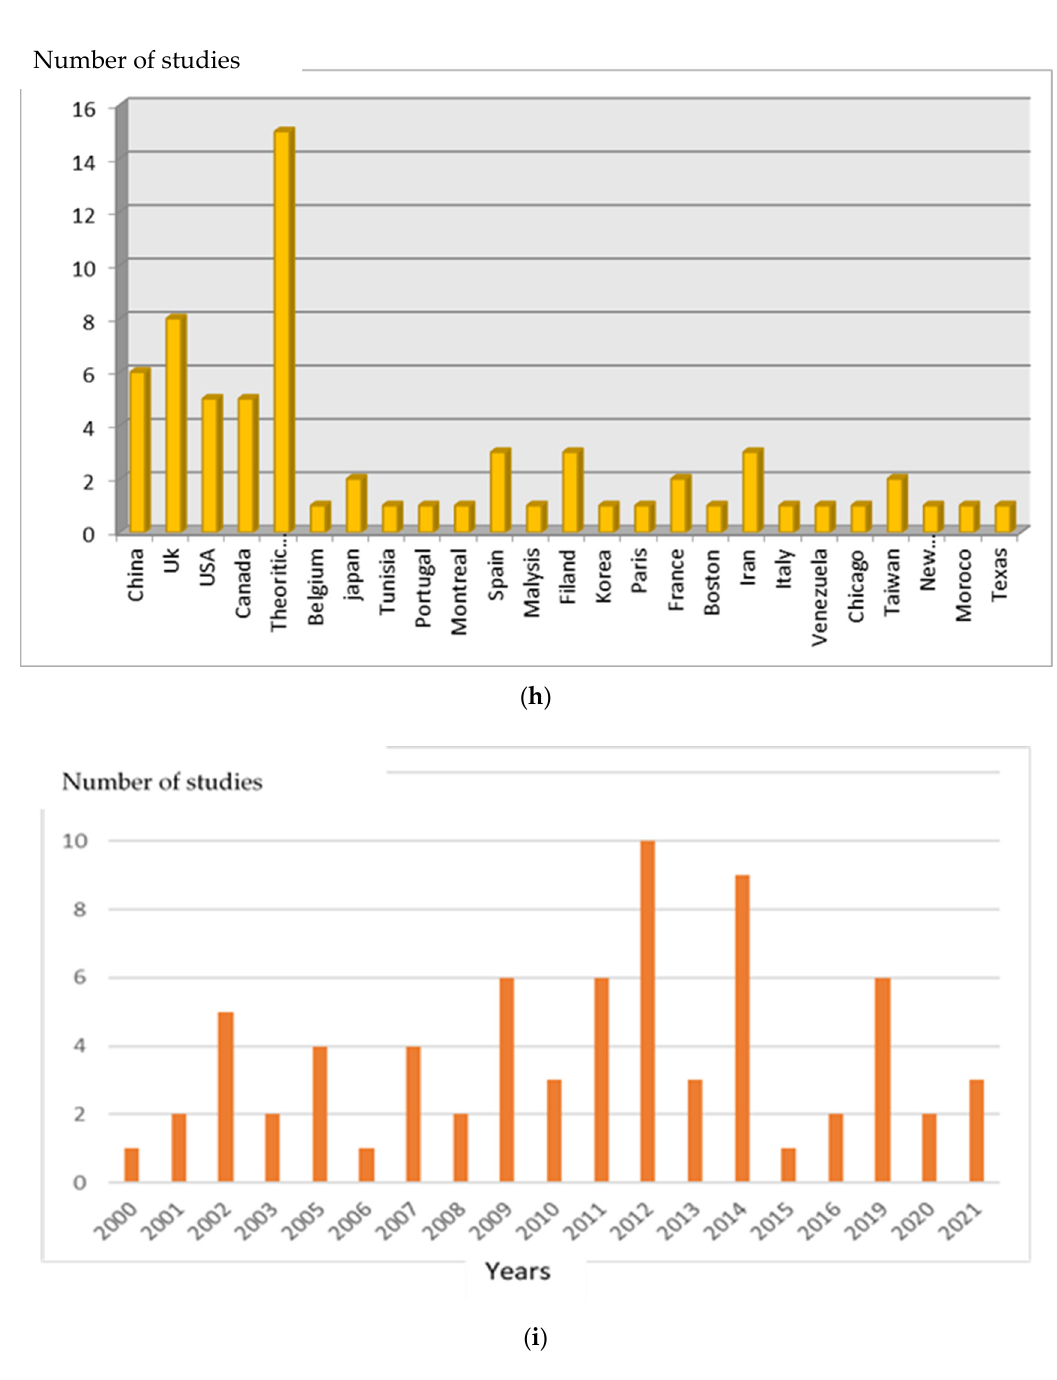
Figure 2. GA statistical information. ( a ) Collection techniques of GA; ( b ) GA objectives; ( c ) variables of genetic scheme; ( d ) area of research; ( e ) applications based on GA; ( f ) GA multi-objective functions; ( g ) investigation of GA as indicated for countries; ( h ) investigation of GA as indicated for countries; ( i ) study of GA according to years.